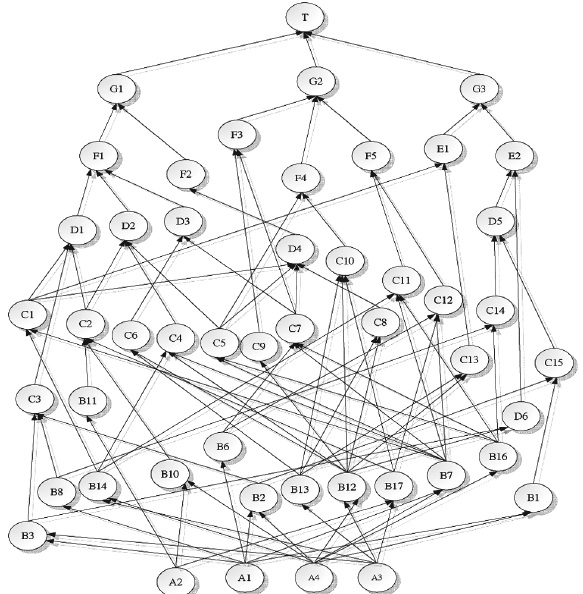
Fig. 4. BN of falling accidents at bridge